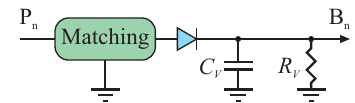
Figure 3. Diode power detector for down-converting the six-port’s output